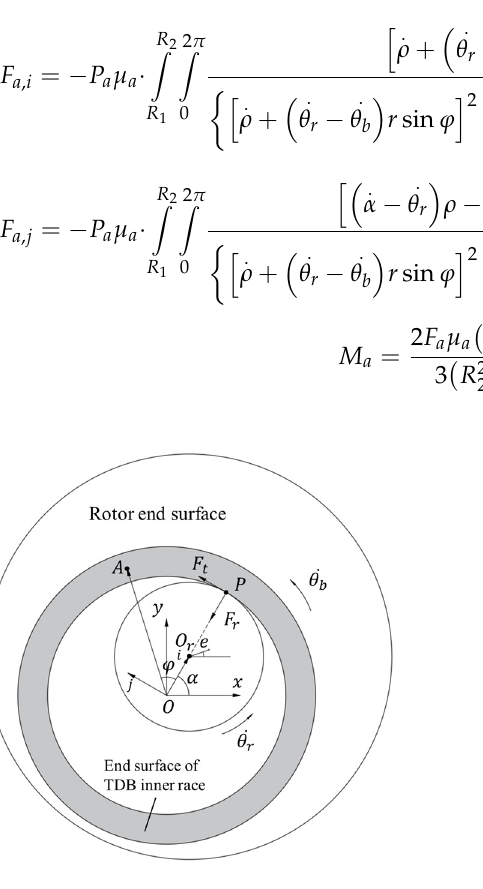
Figure 2. Contact model of the rotor and TDB inner ring.